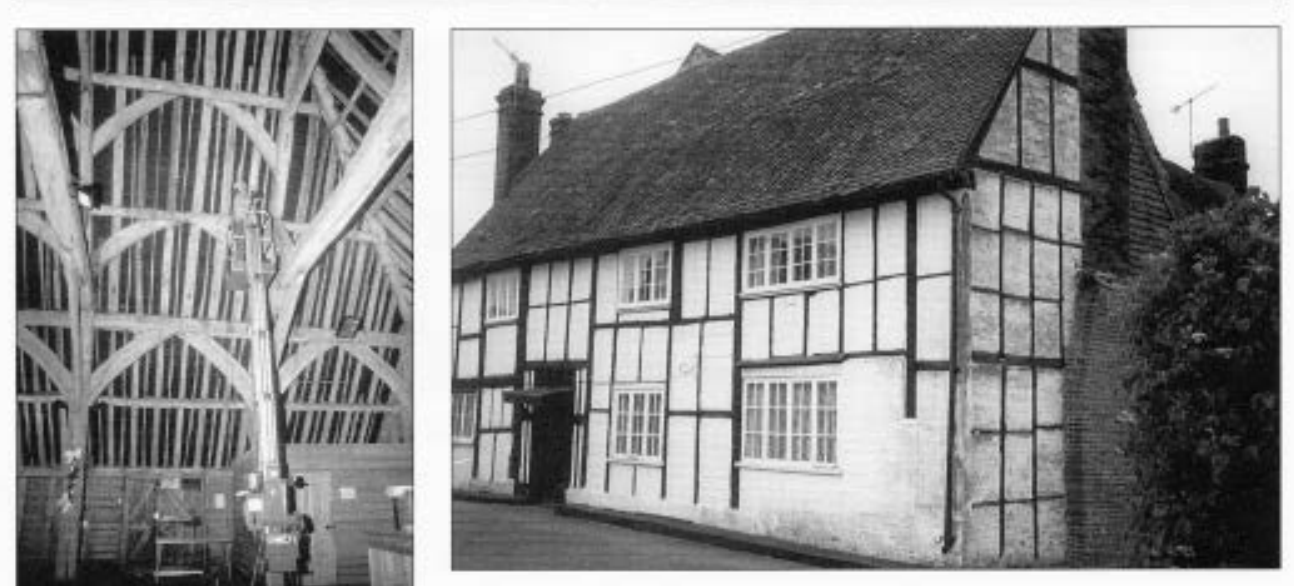
Figure 5 View of the east facade of the farmhouse at Home Farm, Newdigate, Surrey, built of timbers felled in the period 1574-1 603. different in age to the accepted typological Figure 4 Internal view of Priory Barn, date comes from Little Braxted in Essex, Little Wymondley, Hertfordshire, showing the author taking samples for dendra­ chronological study.